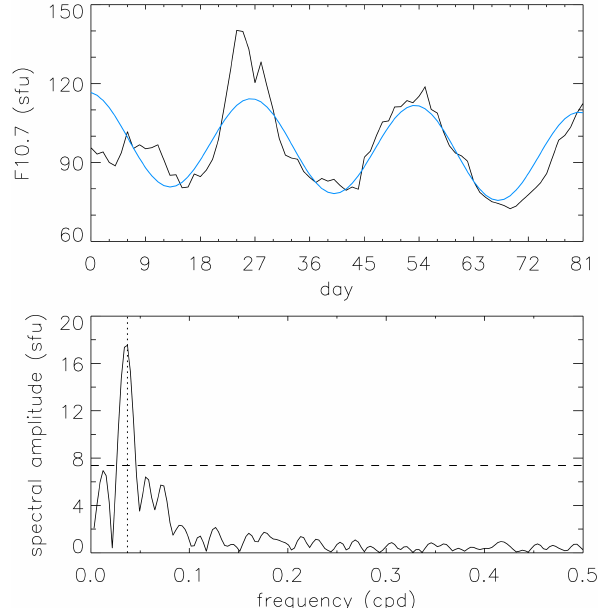
Figure 6. Top: solar 10.7cm flux from NGDC and fitted oscillation. The black line denotes F10.7, and the blue line denotes the sum of fitted oscillation and linear trend. Bottom: Lomb–Scargle spectrum of F10.7. The dotted vertical line corresponds to a period of 27 days, and the dashed horizontal line denotes the confidence level of